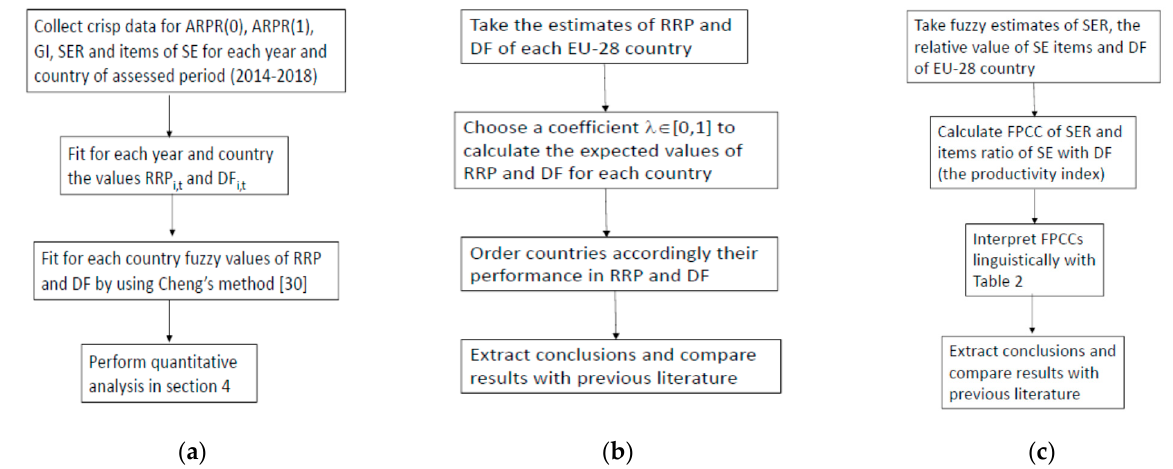
Figure 2. Flowcharts for the analysis of poverty policies in UE-28. ( a ) Fitting fuzzy estimates of variables for the while period 2014–2018. ( b ) Methodology used to rank PPPs. ( c ) Methodology followed to measure the influence of SER and its composition in the productivity of public poverty policies